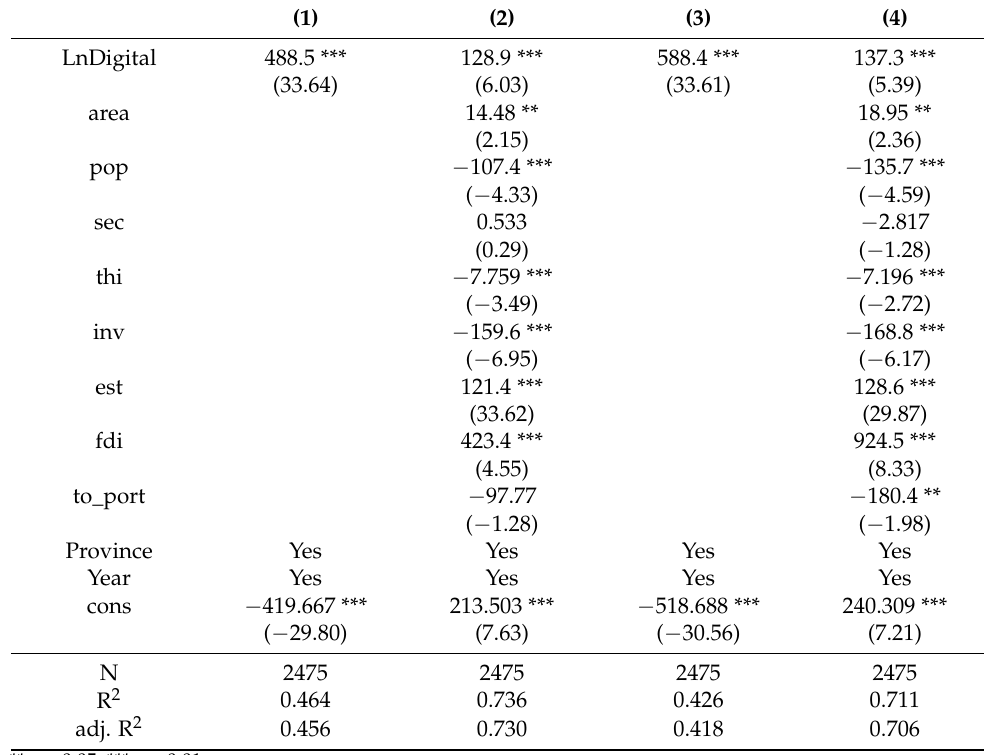
Table 10. Effect of Digital Economy on Corporate Applications for Green